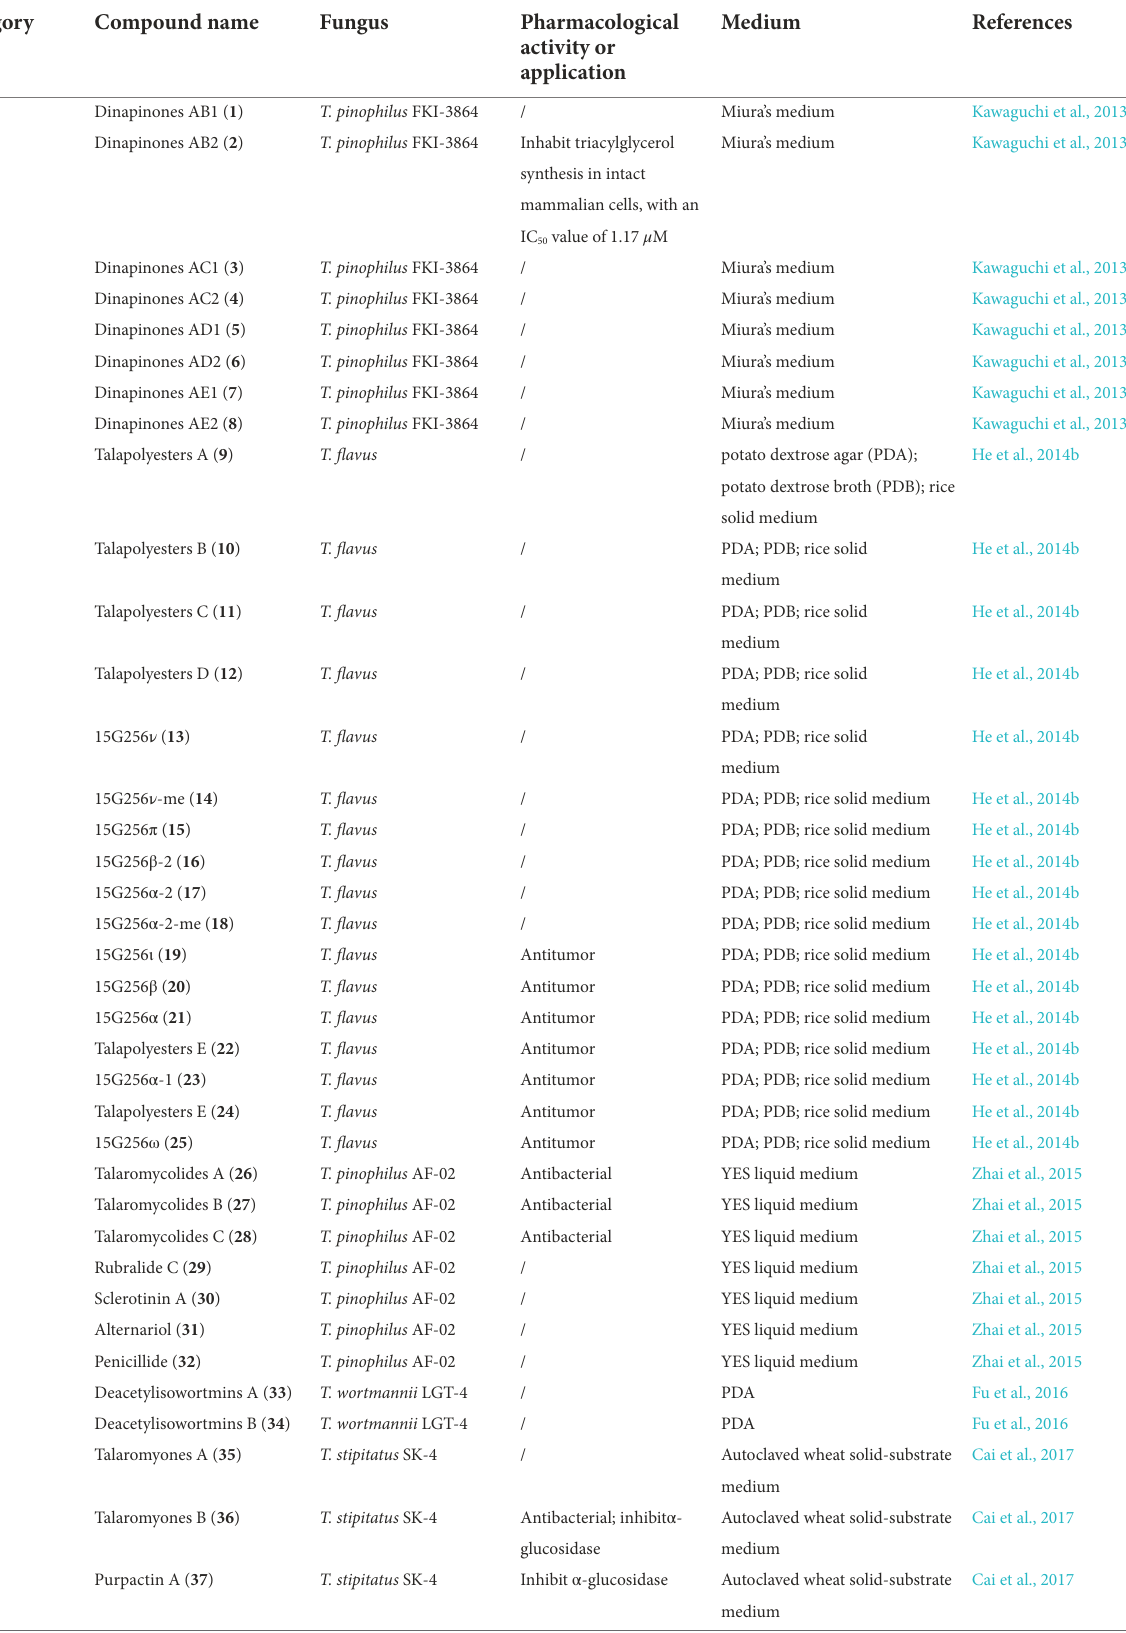
TABLE 1 Name of Talaromyces’ secondary metabolites, source strains, activity and their culture